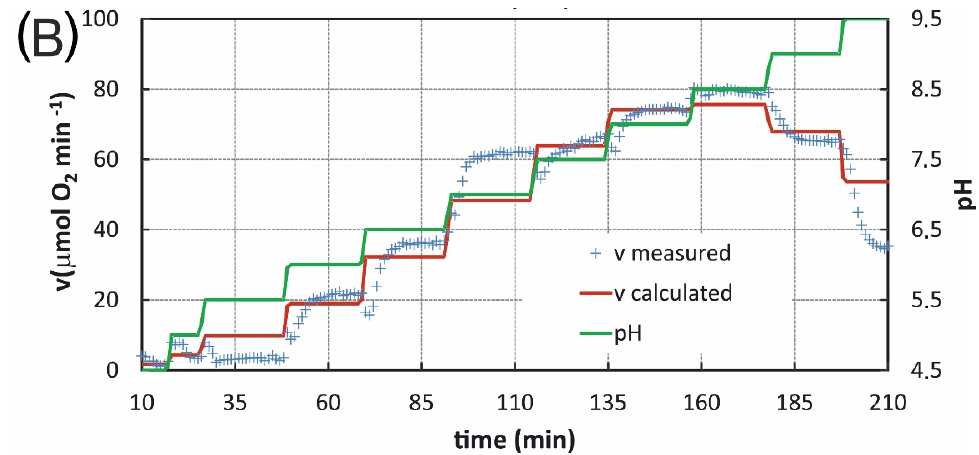
Figure 4. Performance of the ABTOW model in non-equilibrium conditions. Effects of temperature